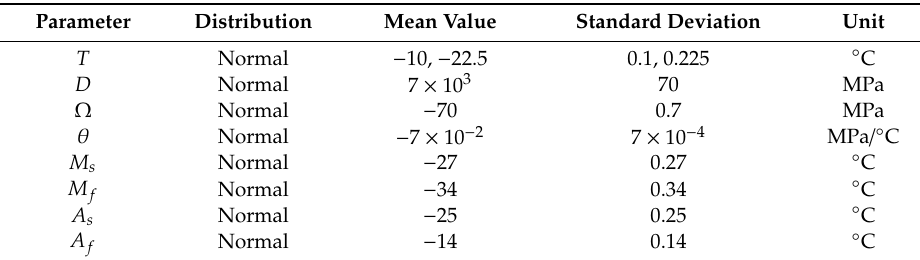
Table 3. Probability distribution for input parameters.